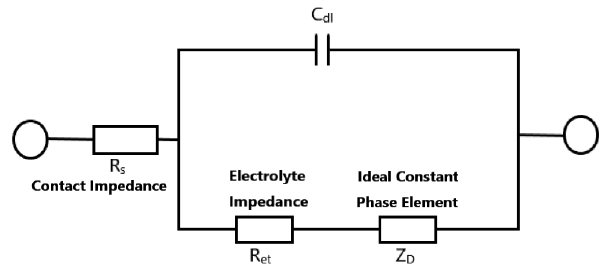
Figure 2. The equivalent circuit model of the ideal Nyquist curve.